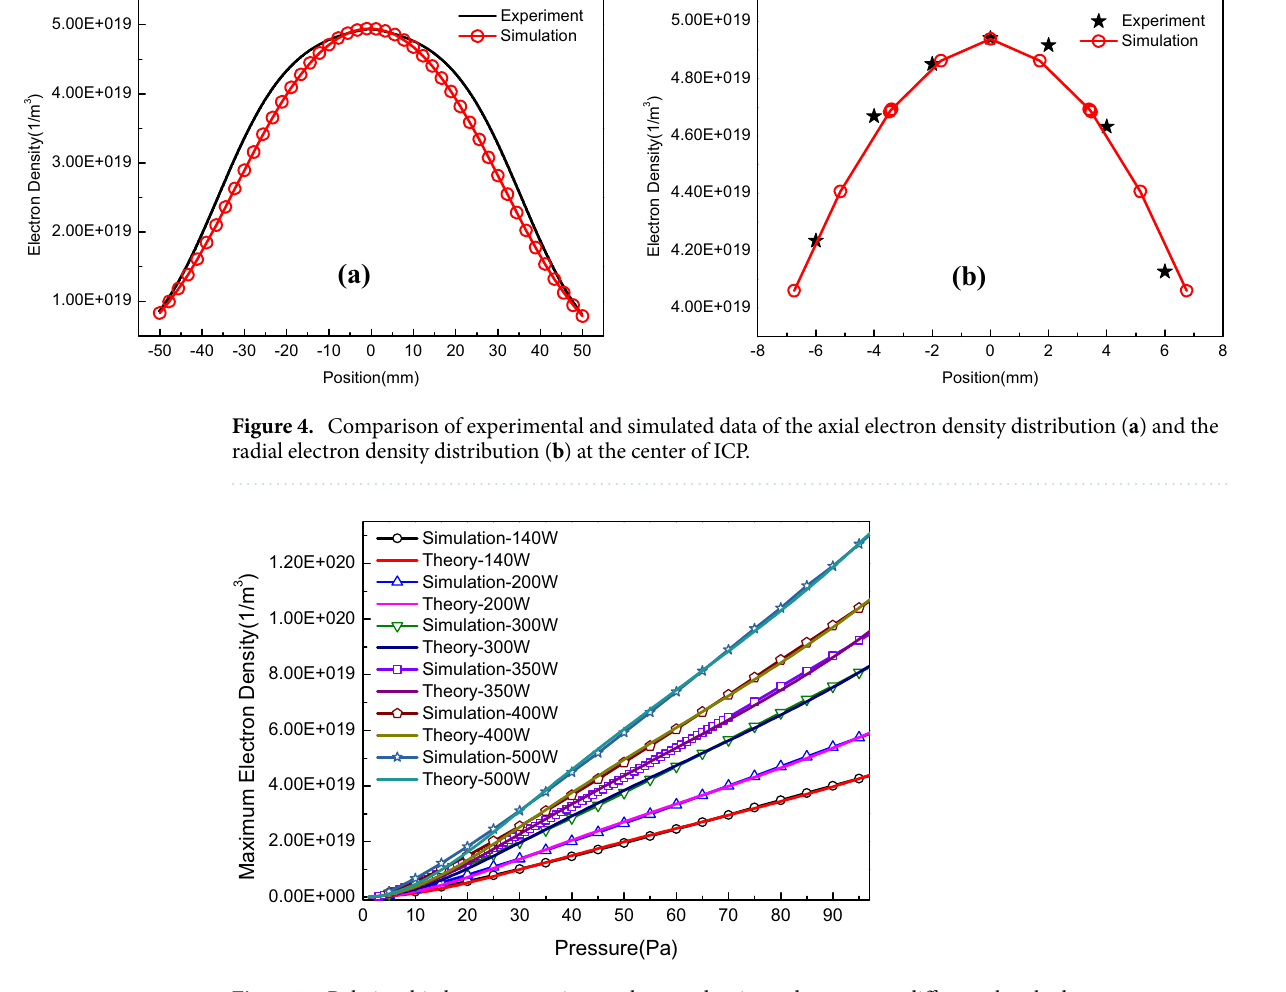
Figure 5. Relationship between maximum electron density and pressure at different absorbed